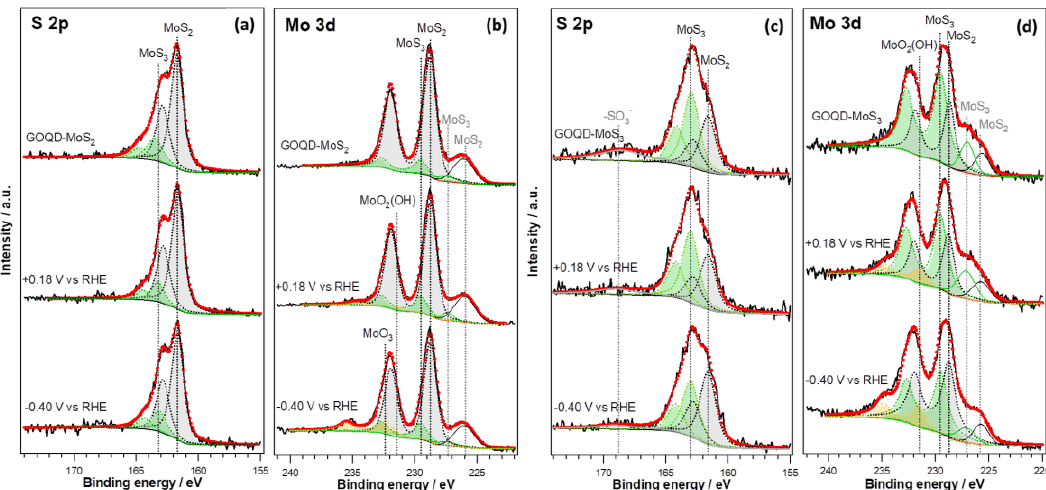
Figure 4. S 2 p ( a , c ) and Mo 3 d ( b , d ) photoemission lines and their separation into chemically shifted components for GOQD-MoS 2 ( a , b ) and GOQD-MoS 3 ( c , d ) before and after the electrochemical measurements in 0.1 M HClO 4 at different potentials. The black and red curves represent the experimental data and the corresponding fit, respectively.